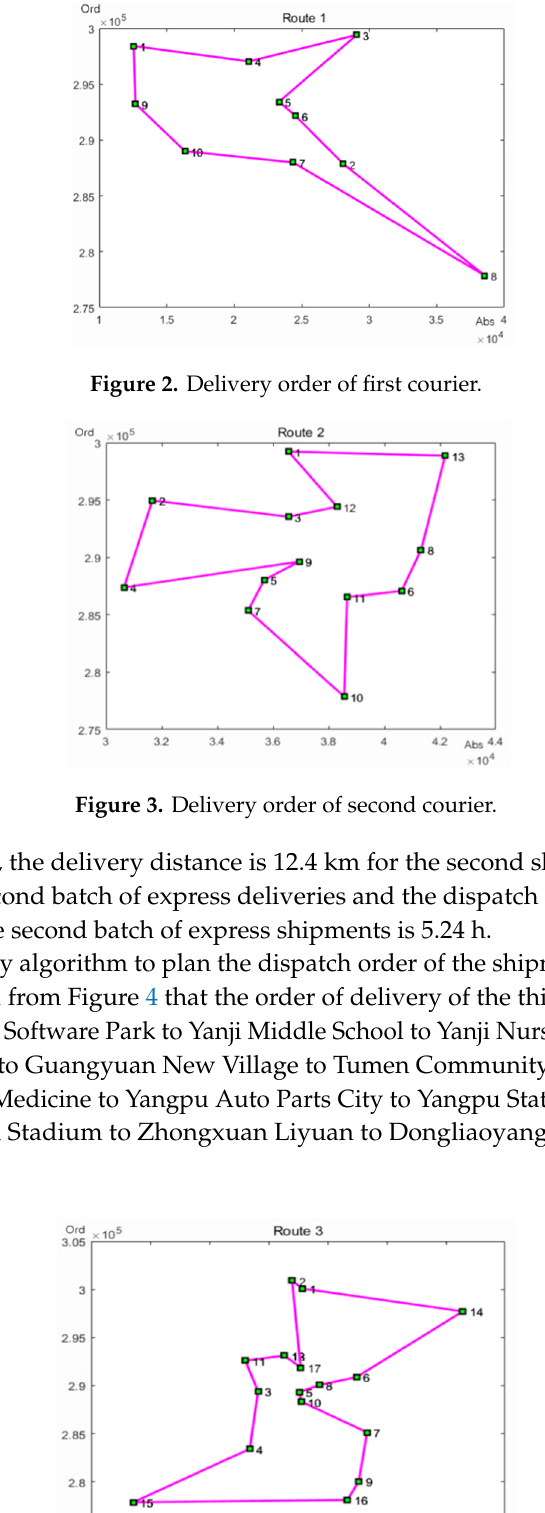
Figure 4. Delivery order of third courier.